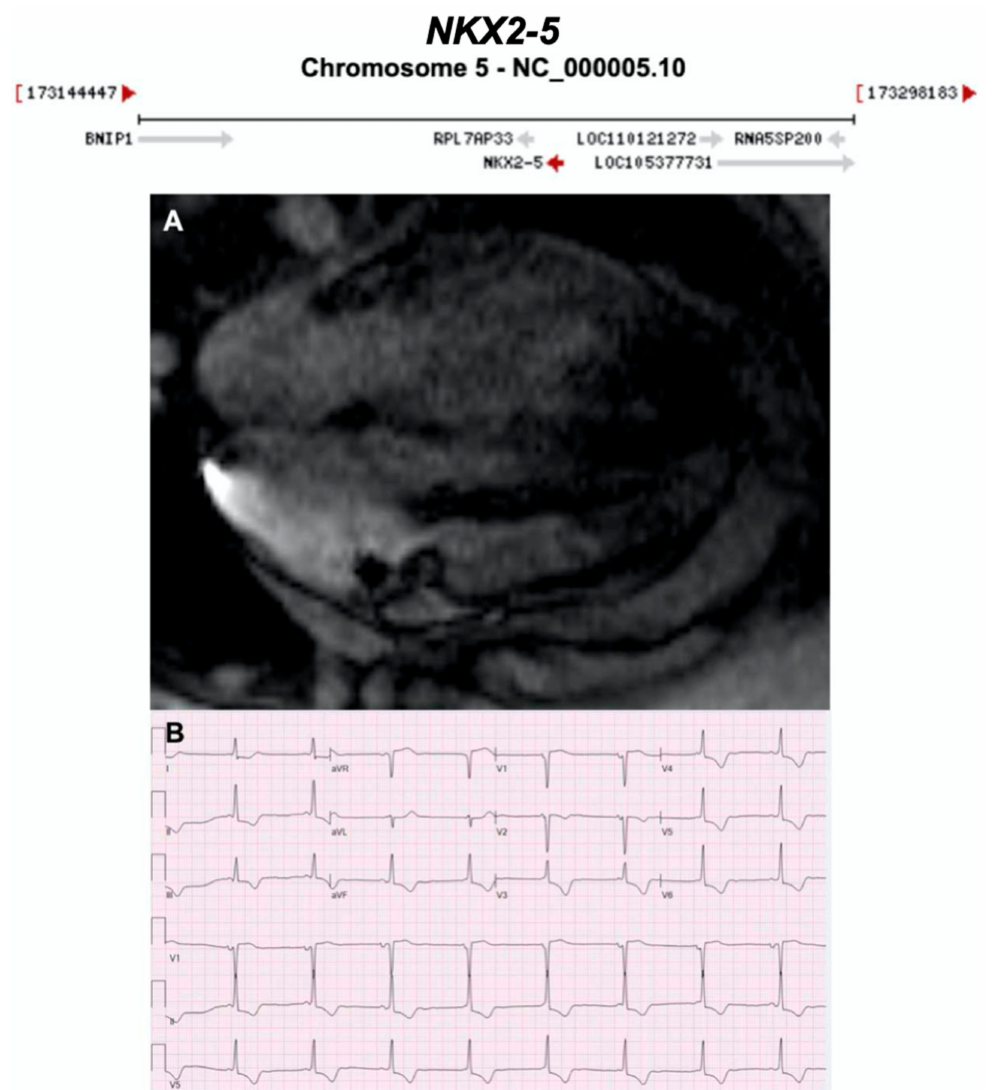
Figure 19. Exemplar MRI and ECG finding found in ACM patients with NKX2-5 mutations. ( A ) A cardiac MRI of a patient with NKX2-5 c.471_472delCA variant showing non-dilated hypokinetic ventricle, no valvular heart disease, no LGE; ( B ) ECG finding of a di ff erent patient with the same NKX2-5 mutation as in ( A ). CMR = cardiovascular magnetic resonance; ECG = electrocardiogram; LGE = late gadolinium enhancement; LV = left Ventricle; RV = right Ventricle. Gene location images taken from https: // www.ncbi.nlm.nih.gov / gene /